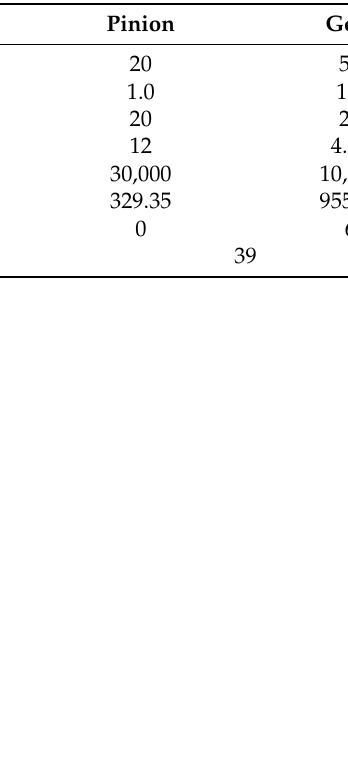
Table 1. Design parameters of spur gear set.